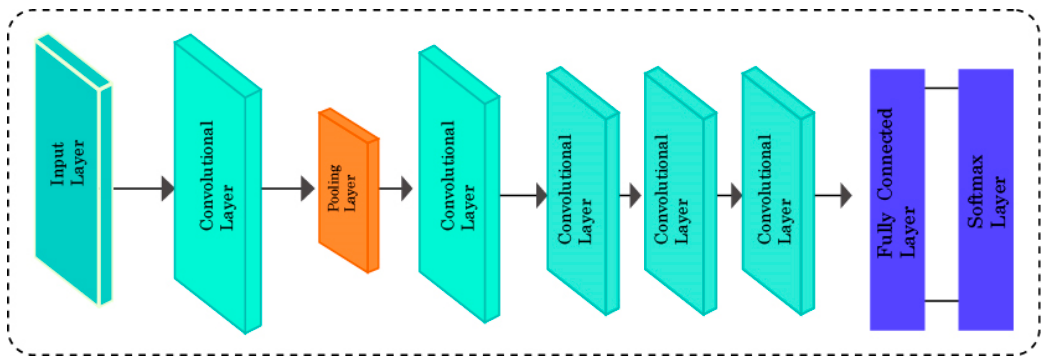
Figure 2. The deep learning architecture for the foreign exchange rate forecasting.